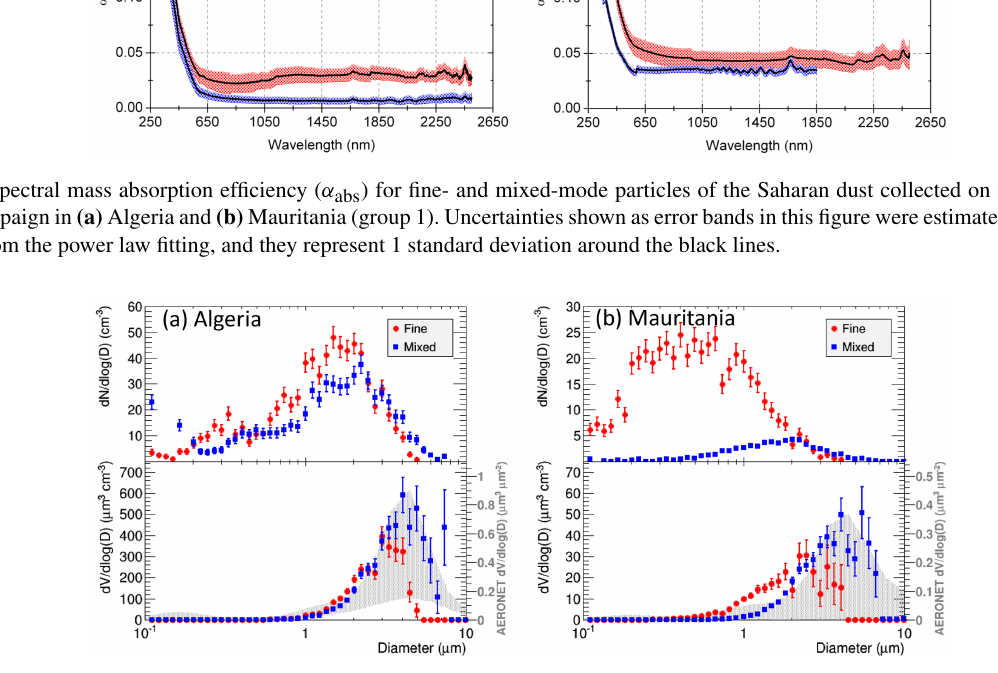
Figure 8. Particle number and volume distribution versus particle diameter obtained by analysis of SEM images for a fine and a coarse filter of Saharan dust sampled in (a) Algeria and (b) Mauritania (group 1). The size distribution obtained by SEM corresponds to the projected area equivalent diameter of the particles. The lower panel in gray shows the AERONET size distribution for the period of the campaign for (a) the BBM site, collocated with the LACO–UMBC aerosol sampling station, and (b) the Zouérat site, approximately 290km from Bir Moghrein. Note that AERONET volume density is per unit area, not volume, and is thus plotted with its own y -axis scale, shown in gray on the right-hand side of the